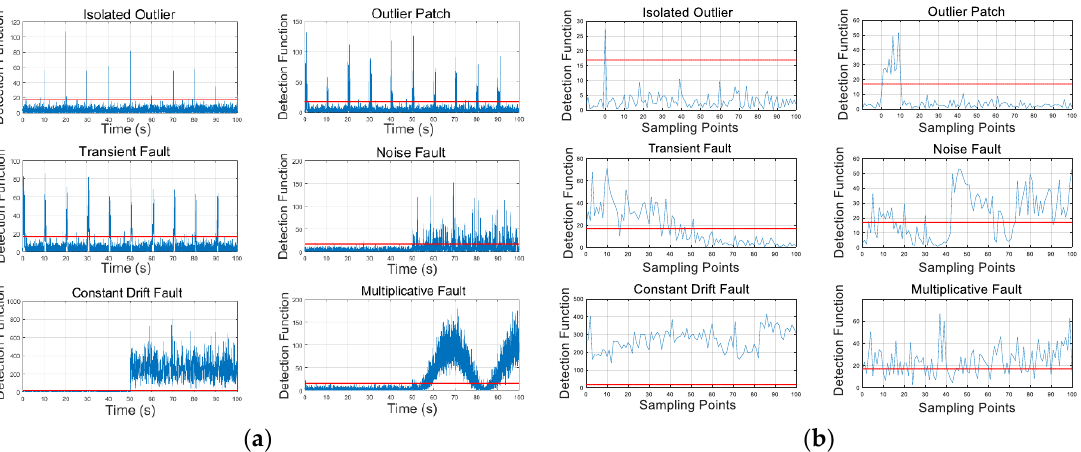
Figure 4. Gyro simulation signals.